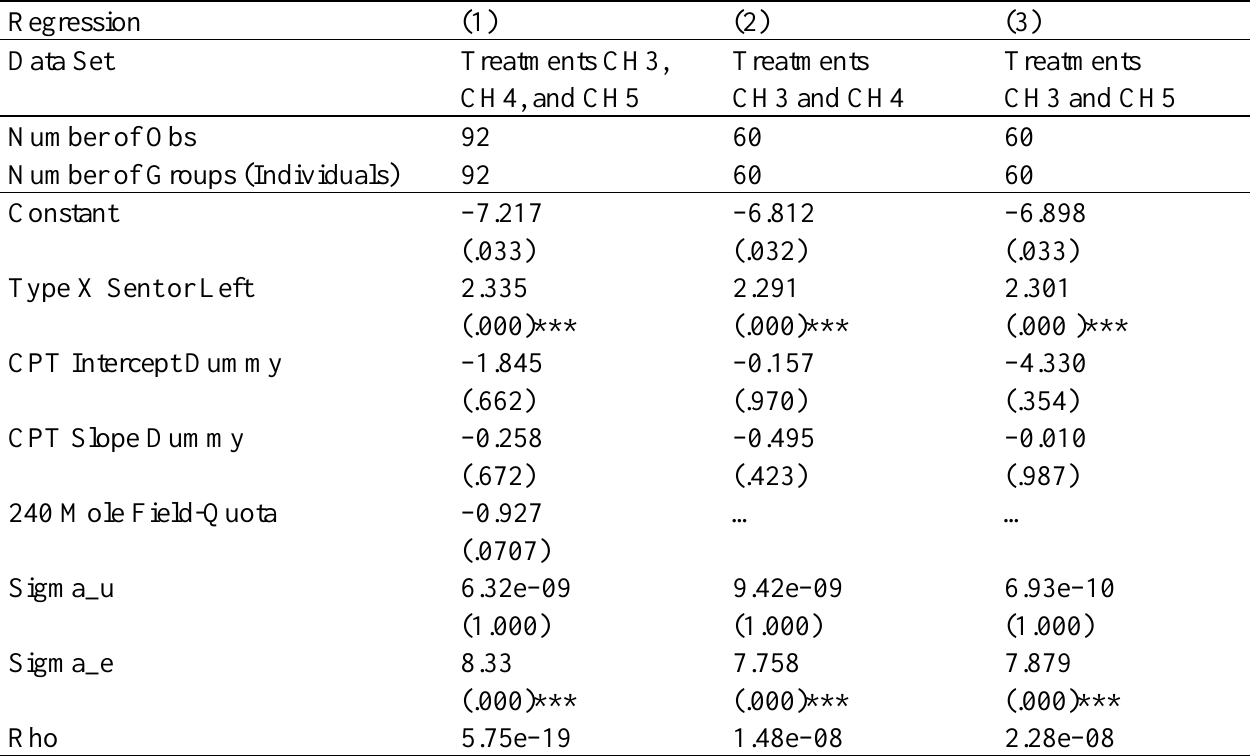
Table A9. Random effects tobit estimations with Type Y data for Treatments CH3, CH4,